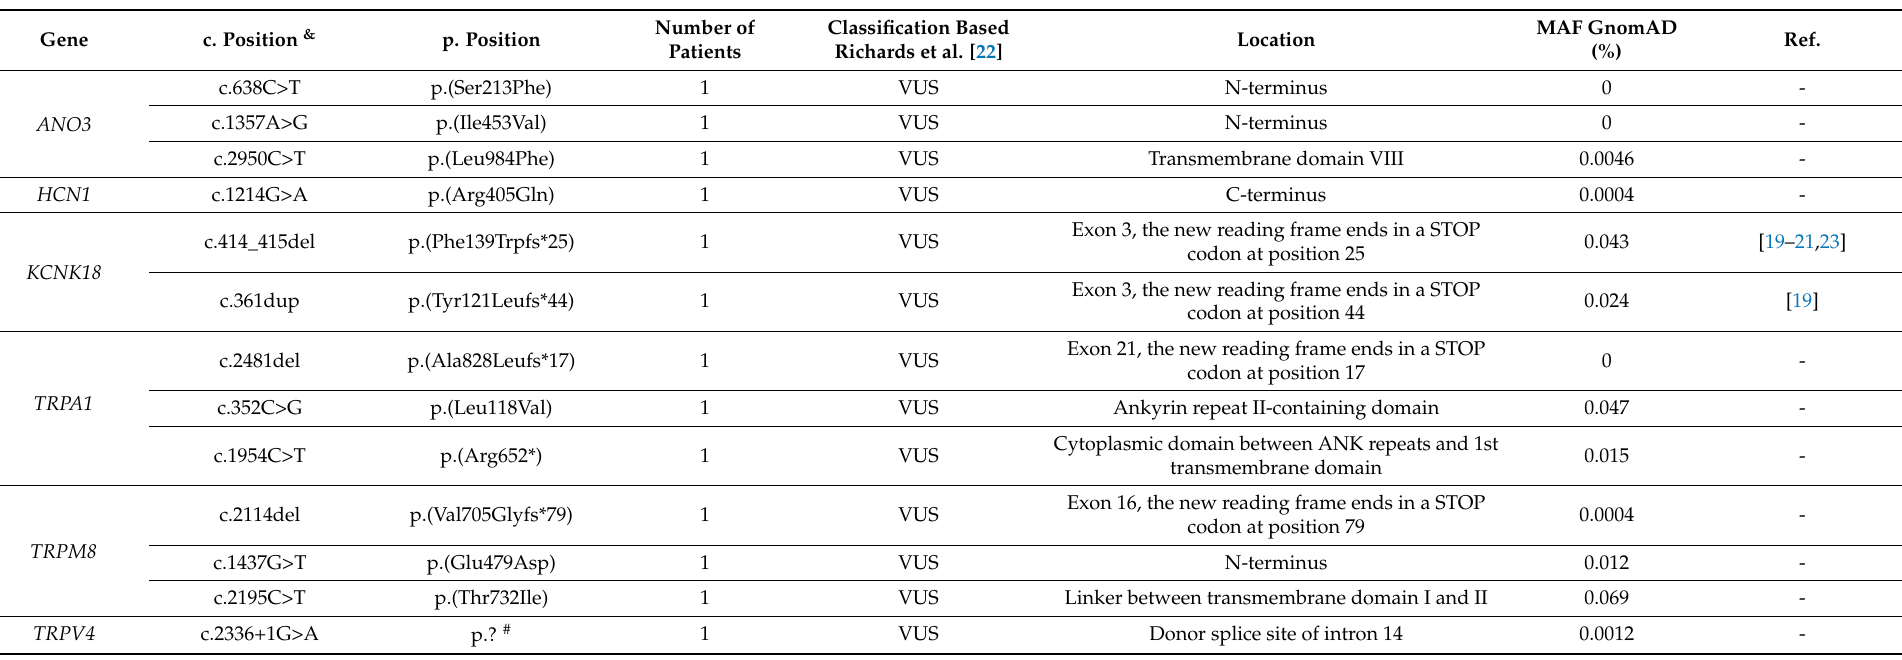
Table 1. Potentially pathogenic variants of ion channel genes identified in patients with painful-diabetic neuropathy ( n =